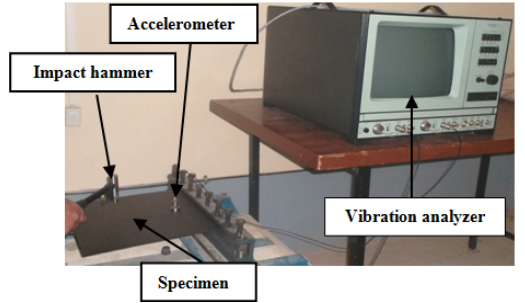
Figure 2. Experimental equipment